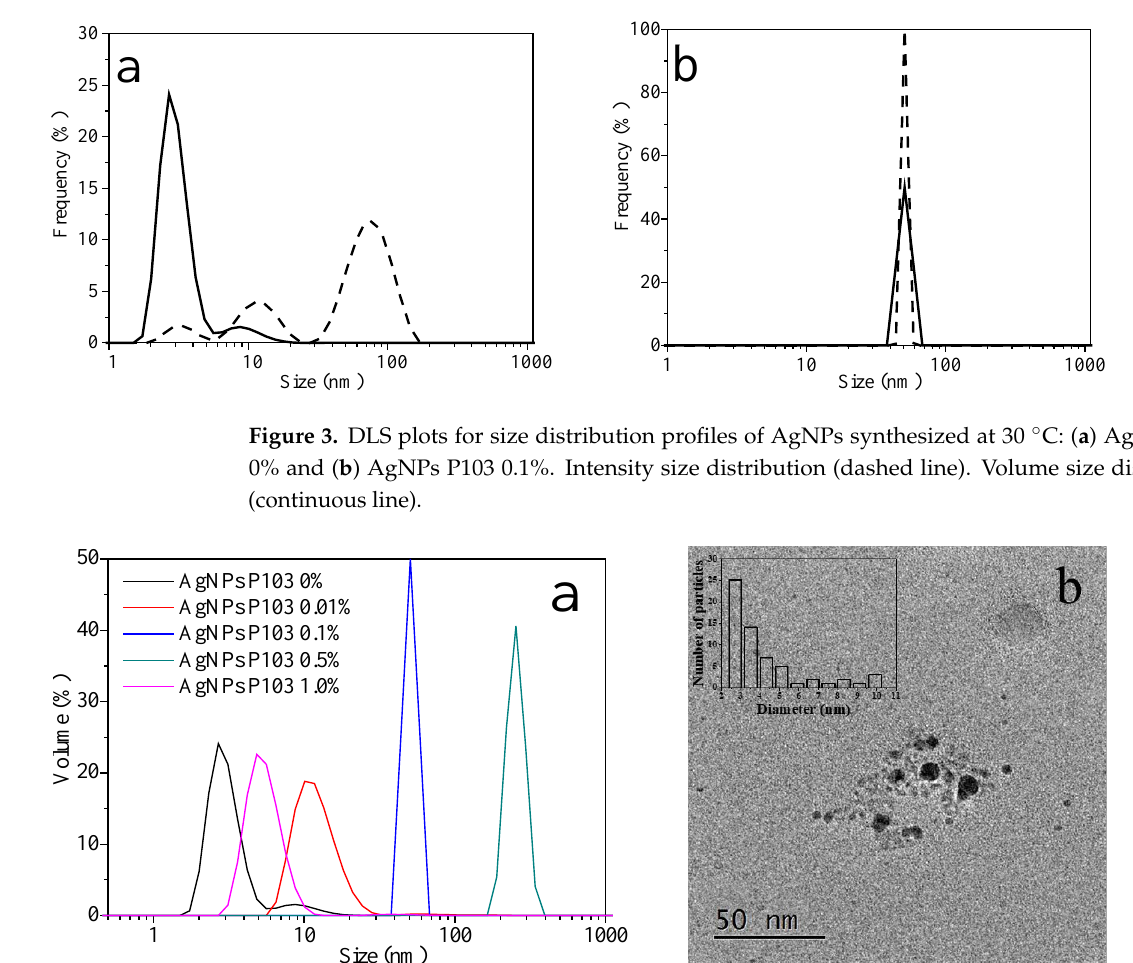
Figure 4. ( a ) DLS plot for size distribution profiles of AgNPs synthesized at 30 °C with and without Pluronic P103 at different concentrations (wt%). ( b ) TEM for AgNPs P103 1%.